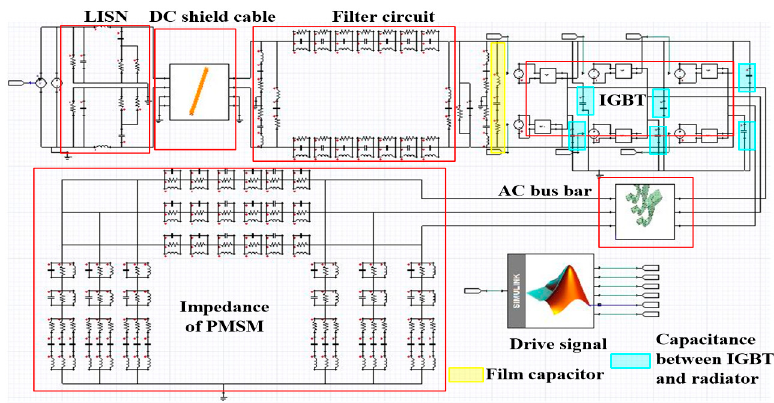
Figure 1. Conducted EMI emission simulation model of motor drive system.